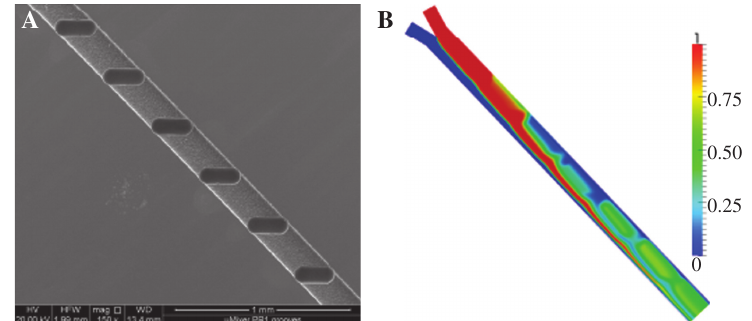
Figure 4 SGM used in the microreactor setup. (A) A SEM image of the micromixer and (B) a numerical simulation of mixing for the applied micromixer. Red and blue represent each of the reactants. A colour table defines mixing index values, where green corresponds to optimal mixing with a mass fraction of 0.5.